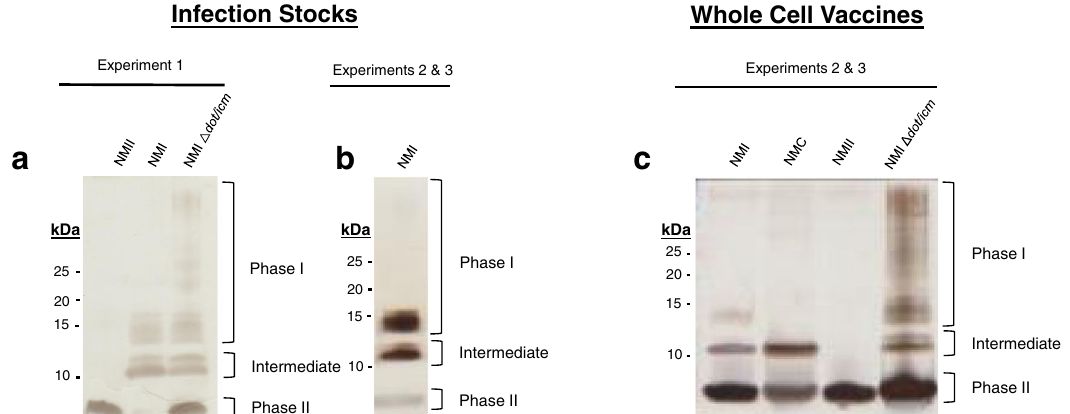
Fig. 2 LPS pro fi les of C. burnetii strains by silver stain. The LPS pro fi les of C. burnetii strains used in this study were examined by silver stain. LPS of live infection stocks used in experiments 1 a and 2 & 3 b , along with whole cell vaccines used in experiments 2 & 3 c are displayed. Silver stain bands corresponding to phase I, intermediate, and phase II LPS, are indicated to the right of each gel while the marker sizes (kDa) are indicated to the